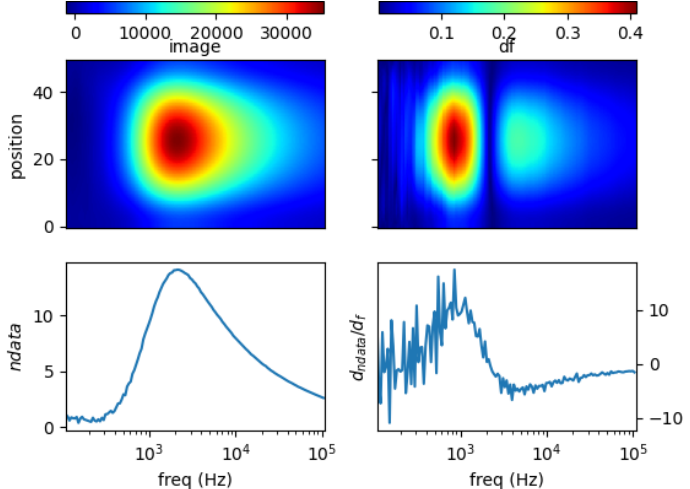
Figure 11. Spectral profile and its derivative (data and reconstructed image values) for a 0.25 inch copper rod ( σ = 58.4 MS /